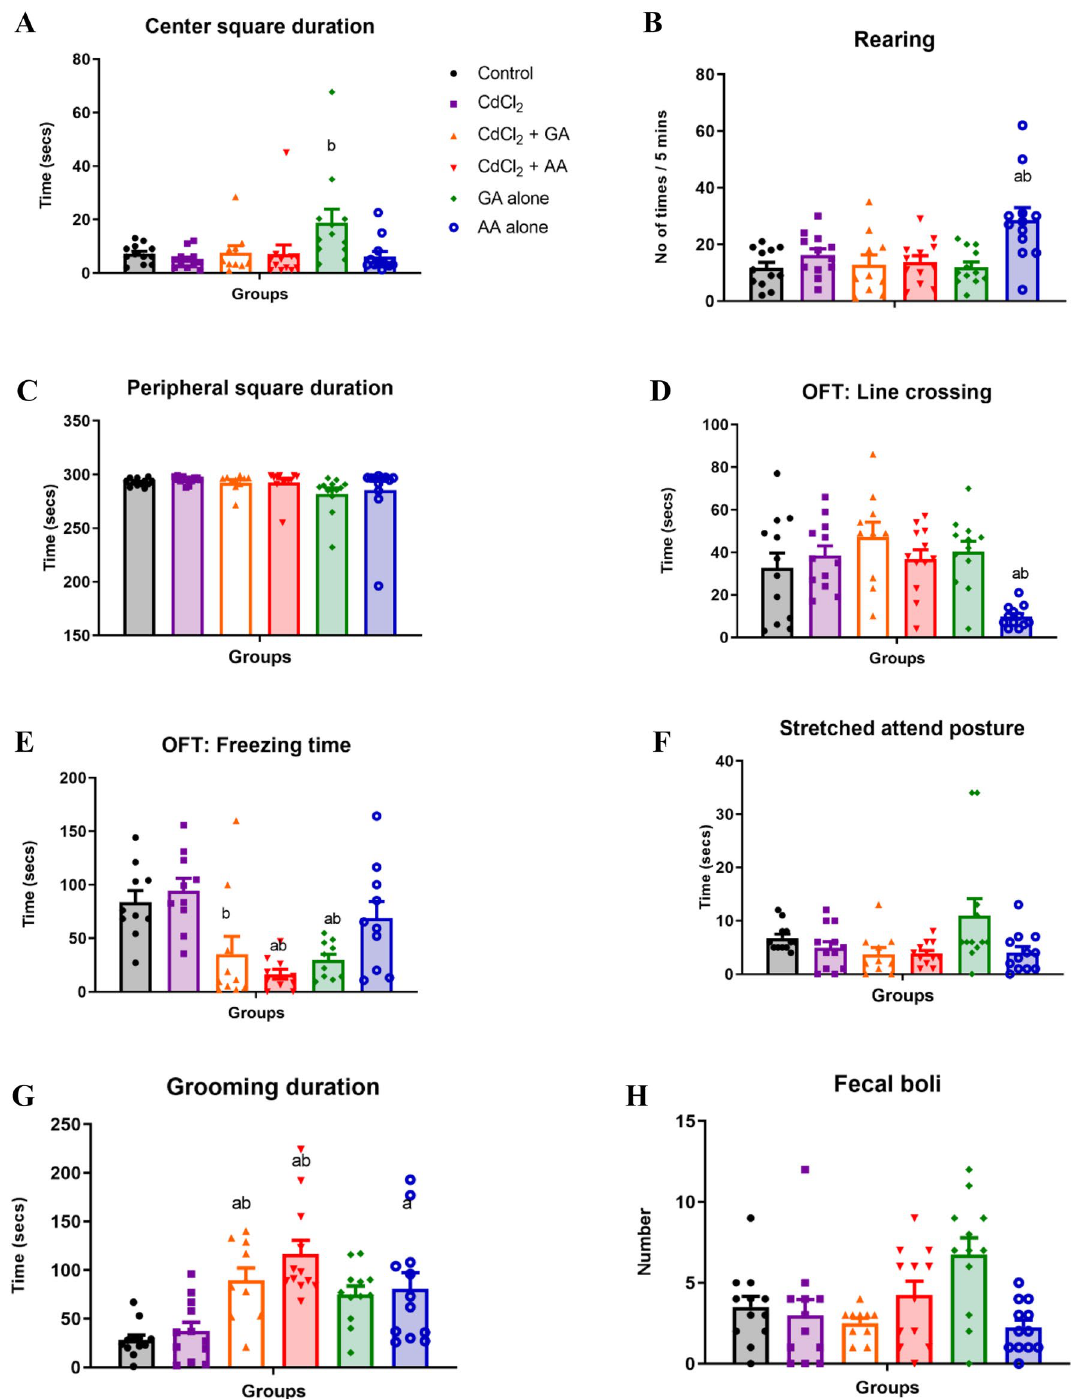
Figure 5. The effects of gallic acid and ascorbic acid on CdCl 2 -induced anxiety and locomotion in the open field test showing ( A ) freezing time ( B ) line crossings ( C ) rearing frequency( D ) grooming duration ( E ) duration of stretched attend posture ( F ) center square duration ( G ) peripheral square duration and ( H ) number of fecal boli. Values are presented as mean + SD. a indicates significant difference at p < 0.05 compared with control b indicates significant difference at p < 0.05 compared with CdCl 2 only group. GA gallic acid, AA ascorbic